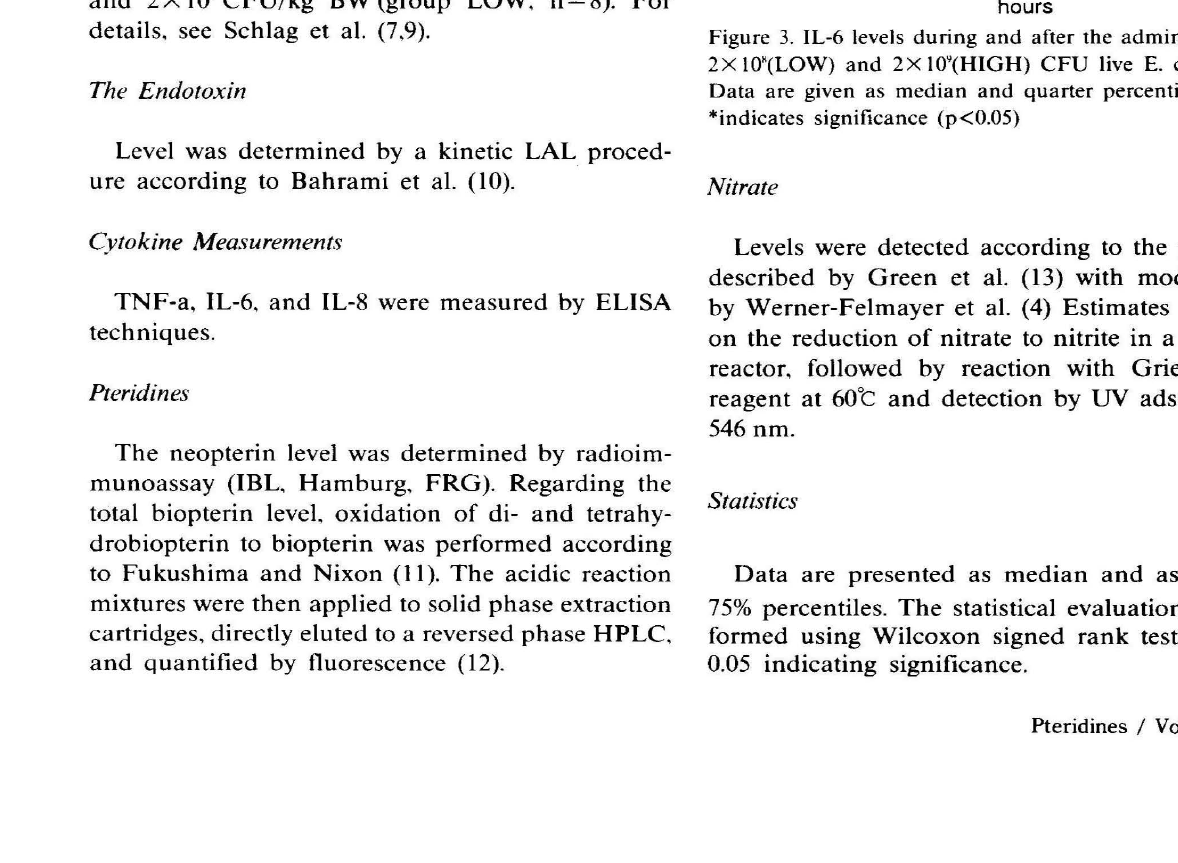
Figure 3. IL-6 levels during and after the administration of 2X 1O'(LOW) and 2X 1O"(HIGH) CFU live E. coli/kg BW. Data are given as median and quarter